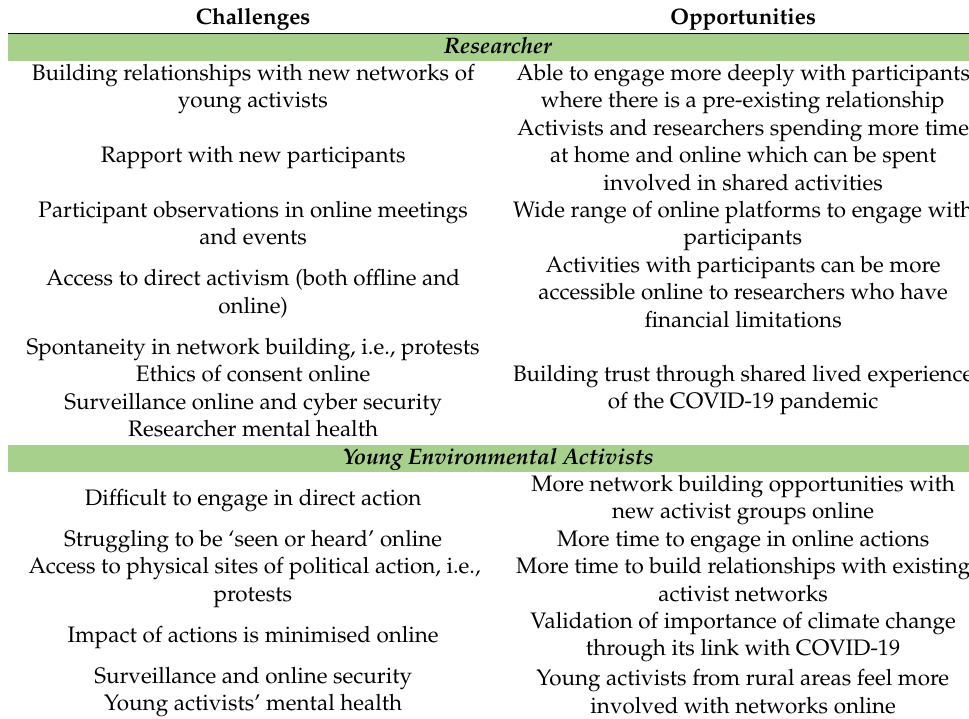
Table 1. Matrix of challenges and opportunities for researchers and young environmental activists during the COVID-19 pandemic and related regimes of